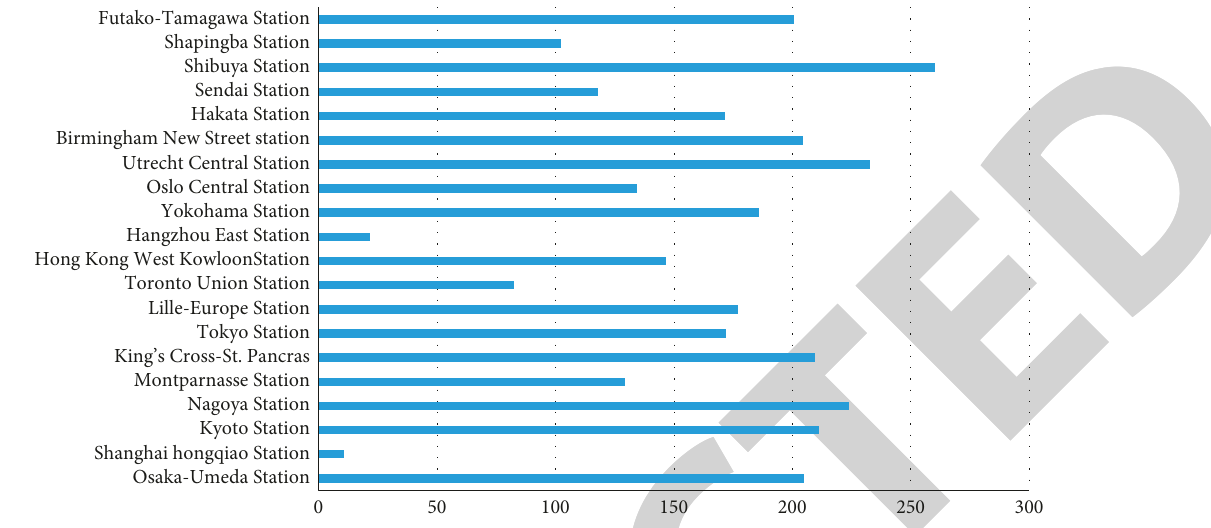
Figure 6: Corrected data of intersection quantity of road